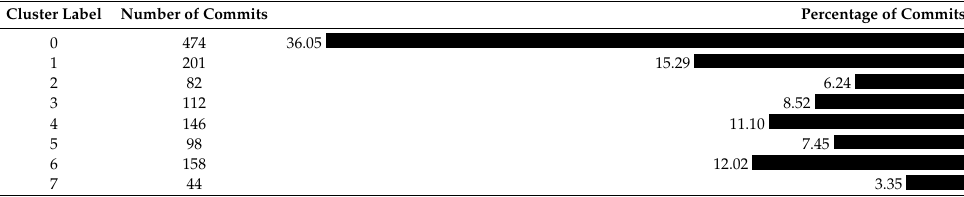
Table 5. AliDPG—distribution of clusters.